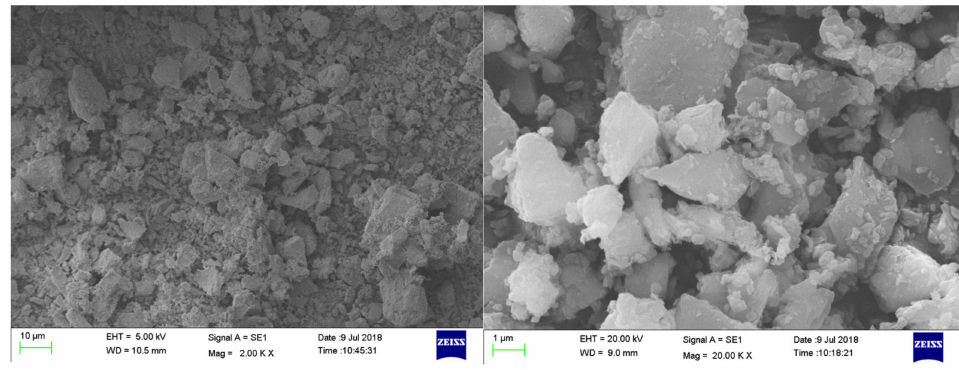
Figure 2. SEM morphology of